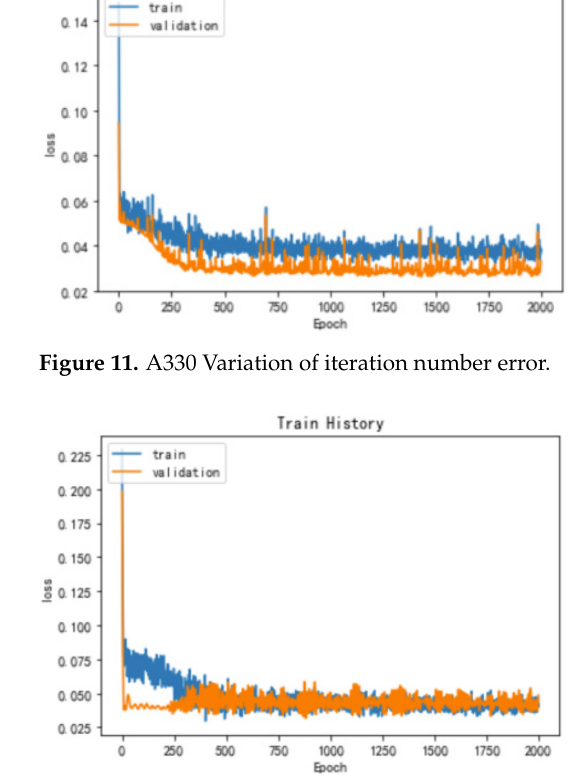
Figure 12. A330 Variation of iteration number error. Figure 12. A350 Variation of iteration number